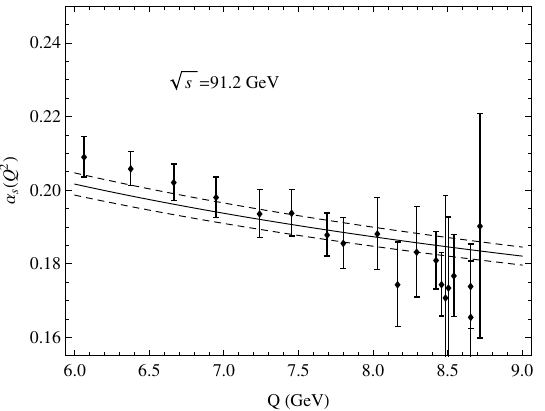
Figure 12. The extracted running coupling α s ( Q 2 ) from the thrust ( 1 − T ) distribution by comparing the PMC predictions with the ALEPH data [1] measured at a single energy of a comparison, the solid line is the world average evaluated from α dashed lines represent its uncertainty.